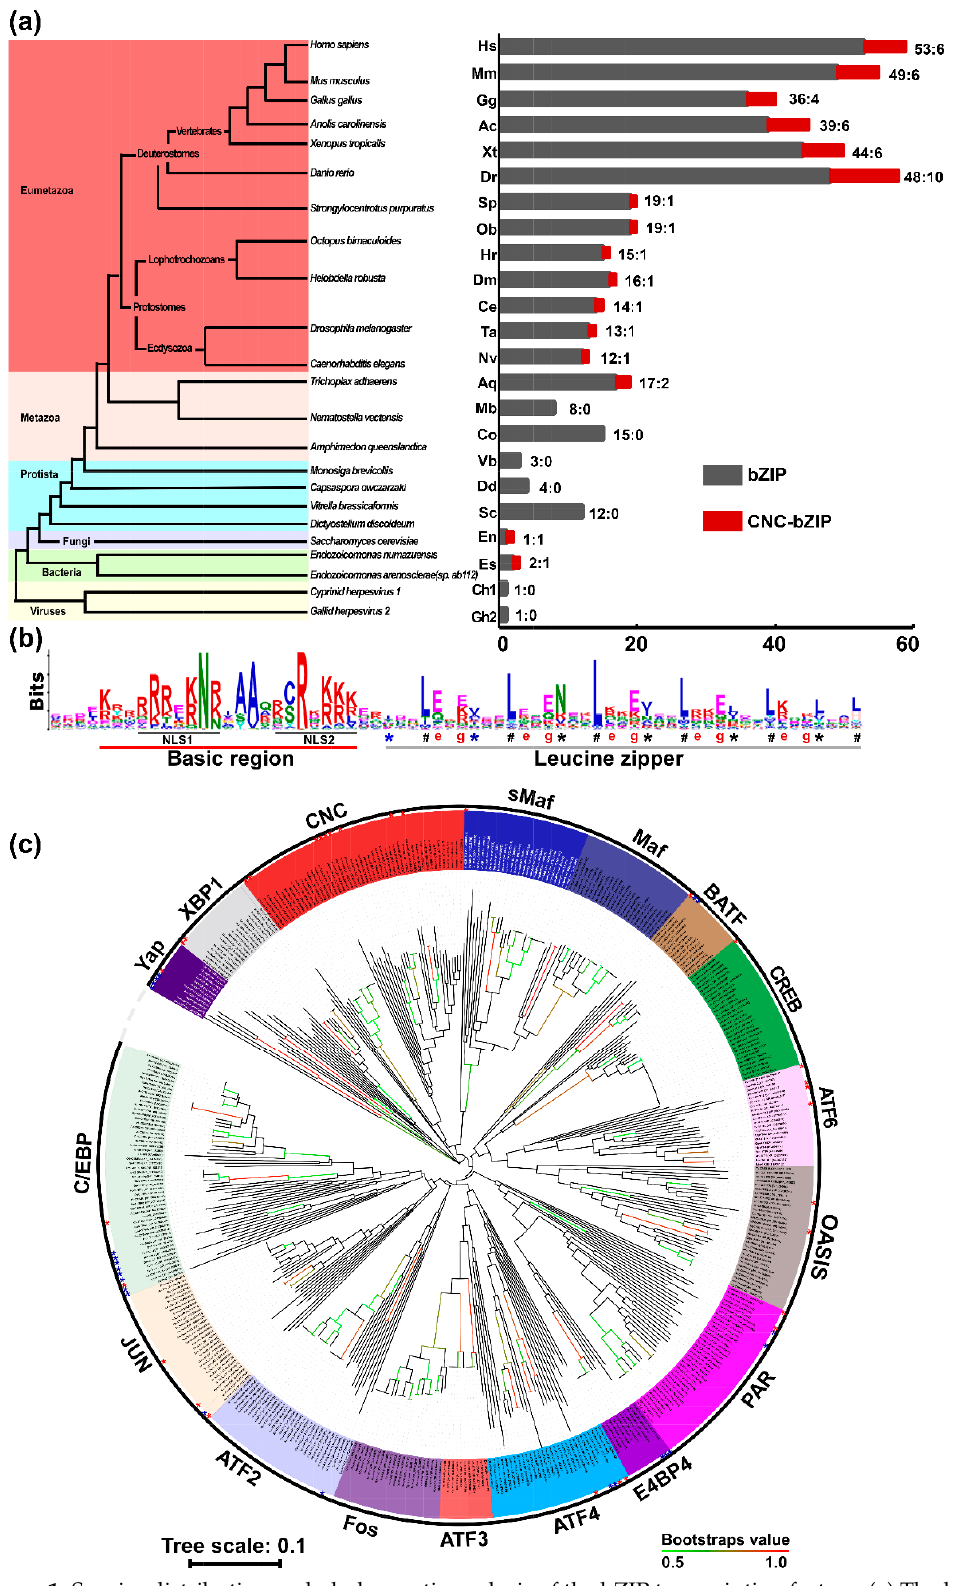
Figure 1. Species distribution and phylogenetic analysis of the bZIP transcription factors. ( a ) The left panel shows distinct evolutionary status of representative species with distinct organisms, while the right graph illustrates discrepant distribution of total bZIP (in black column) and particular Nach/CNC-bZIP proteins (in the dark red column) existing in each of different species. They include Gallid herpesvirus 2 (Gh2), Cyprinid herpesvirus 1 (Ch1), Endozoicomonas numazuensis (En), Endozoicomonas arenosclerae (or sp. ab112) (Ea/Es), Dictyostelium discoideum (Dd), Vitrella brassicaformis (Vb), Saccharomyces cerevisiae